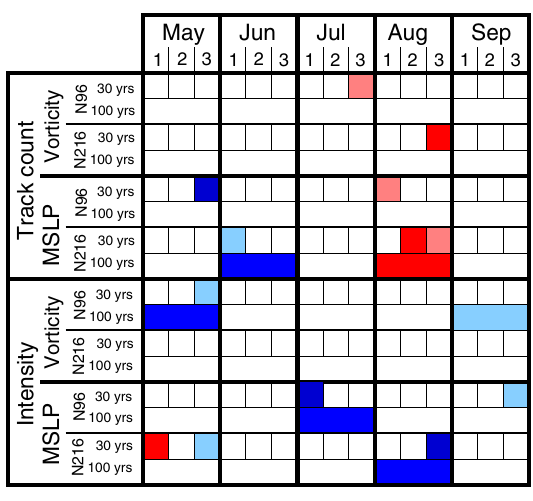
Figure 8. Impact of temporal sampling, demonstrated by correla- tions over the 100-year period and different, discontinuous, 30-year subsets of output from GC2-N96 and GC2-N216 runs. Colours de- note sign of, and confidence in, Pearson correlation coefficients be- tween May, June, July, August and September cyclone character- istics (over Arctic non-land points) and September mean sea ice extent. Dark red squares denote positive correlations significant at the 95% confidence level, light red squares denote positive corre- lations significant at the 90% confidence level, dark blue squares denote negative correlations significant at the 95% confidence level and light blue squares denote negative correlations significant at the 90% confidence level. White squares indicate correlation is not significant at 90% confidence or higher. Columns marked “1”: first 30 years of the 100-year period. Columns marked “2”: middle 30 years of the 100-year period. Columns marked “3”: last 30 years of the 100-year